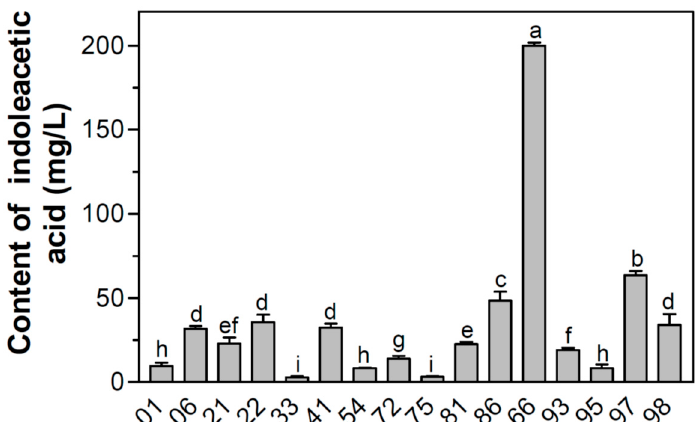
Figure 1. Screening of indoleacetic acid (IAA)-producing strains isolated from the maize rhizosphere soil collected from Shenyang Agricultural University, China, in which colony 66 is strain LX3. Error bars were calculated by standard deviations from triplicate runs for IAA production assay. Different letters on top of bars indicate significant differences ( p < 0.05).